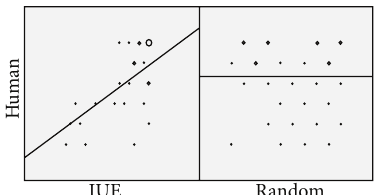
Figure 4: Visualizing the correlation between the IUE tool, random baseline, and human annotators for the task of detecting heading- to-heading uniqueness.